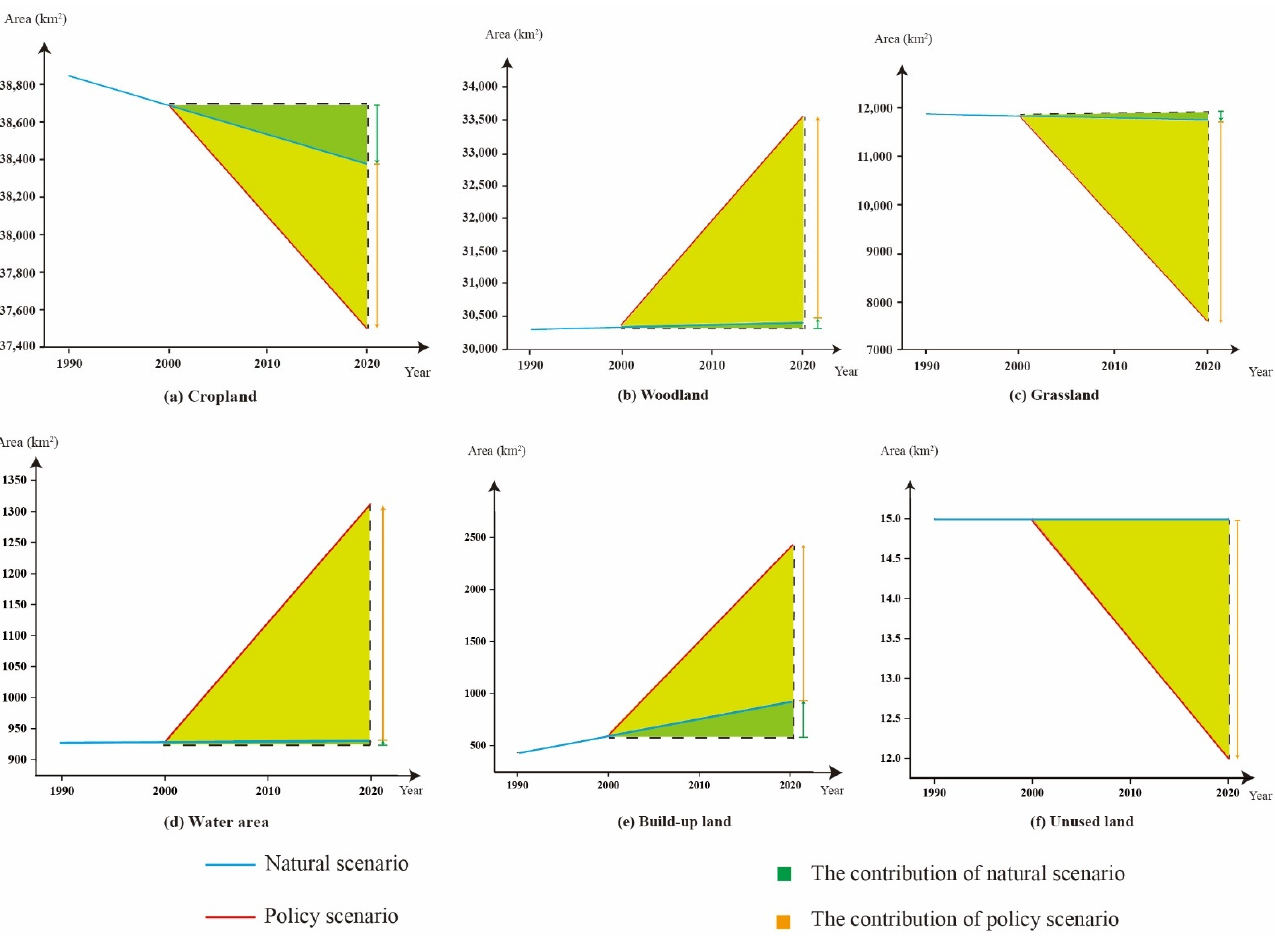
Figure 6. ( a – f ) indicate the trends in the amount of cropland, woodland, grassland, water area, built- up land, and unused land under the two scenarios from 1990 to 2020, respectively, and the contri- butions of the two scenarios to various land use types.